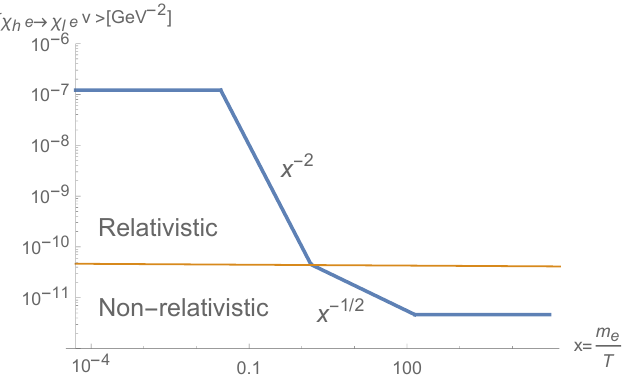
Figure 15 . Thermally averaged cross section for a DM mass of 10 MeV, mass splitting of 10 − 2 MeV, and m = 5 m . We can observe that the cross section is constant for both high and low A 0 χ l temperatures, but in the middle it has a non-trivial dependence on the